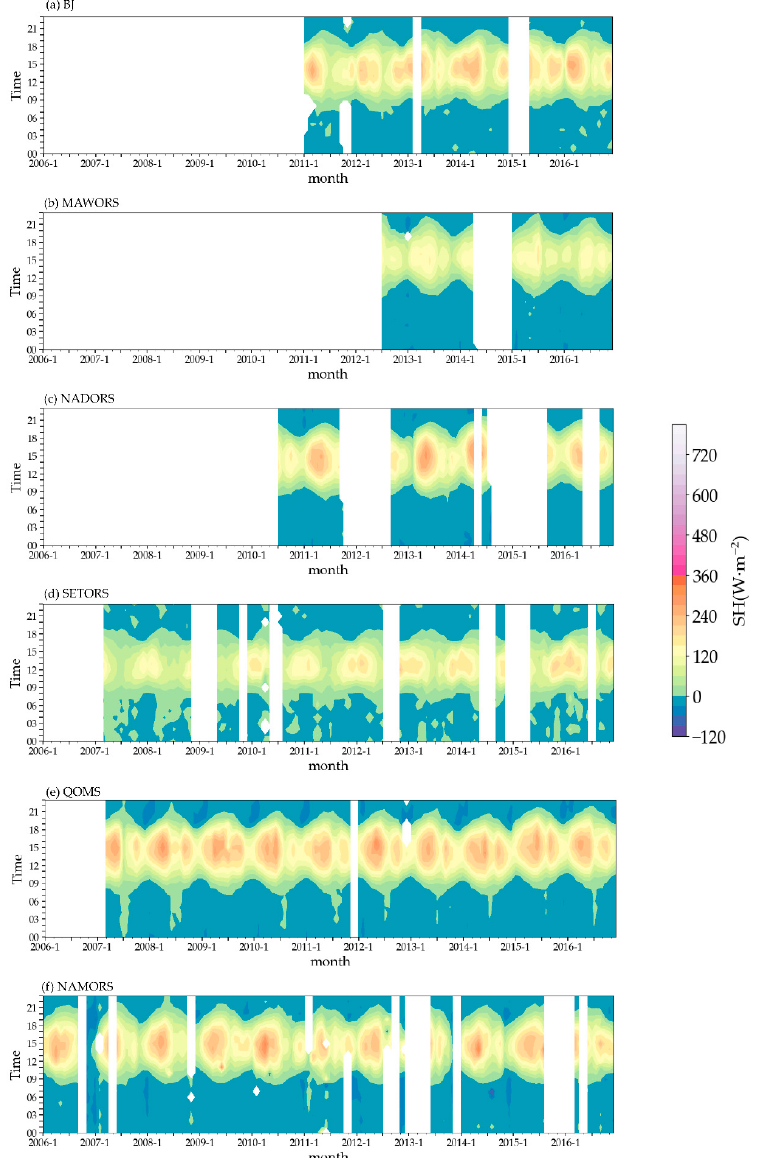
Figure 4. Monthly mean of the diurnal variation in observed SH (shaded, W m − 2 ) at ( a ) BJ, ( b ) MAWORS, ( c ) NADORS, ( d ) SETORS, ( e ) QOMS, and ( f ) NAMORS during the period 2006–2016.